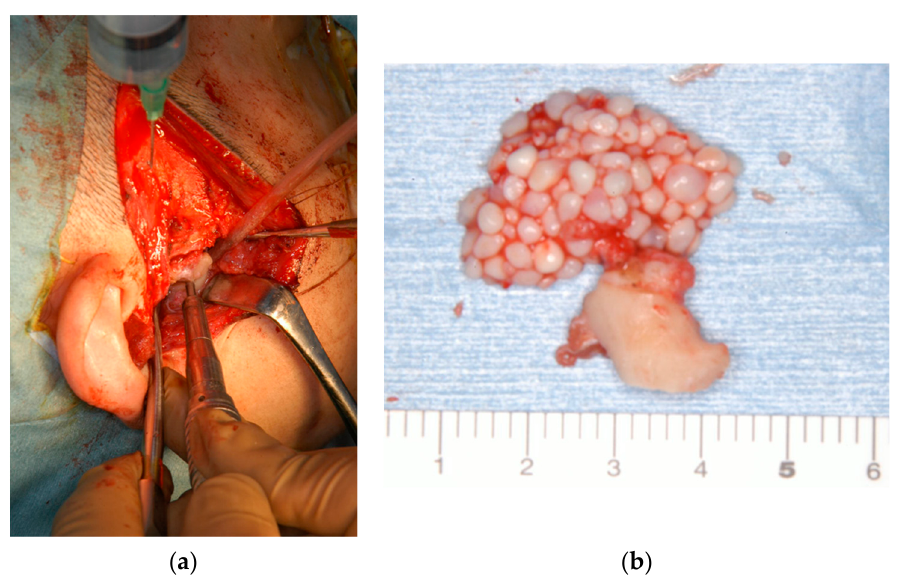
Figure 2. Photographs of intraoperative and excised material in patient 1. ( a ) Intraoperative photo- graph. We performed a preauricular incision and tumor resection, including the synovial disc and right head of the mandible by open-joint capsule surgery under general anesthesia. ( b ) Excised ma- terial from patient 1. The mandibular head was deformed, and the disc was perforated. A total of 151 free hard solid objects resembling rice bodies were found in the superior joint space.